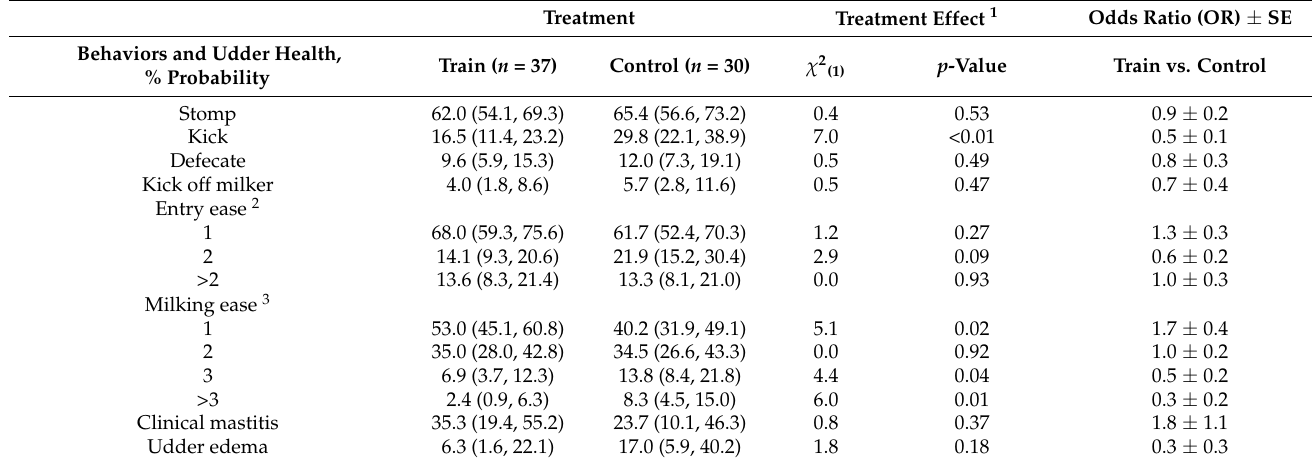
Table 3. The probabilities (95% CI) of behaviors occurring during milkings and of the development of clinical mastitis and udder edema over the first 3 d of lactation in heifers receiving a weekly 1.0% iodine-based teat dip in the parlor 3 weeks prior to calving (trained) or no treatment (control) based on logistic